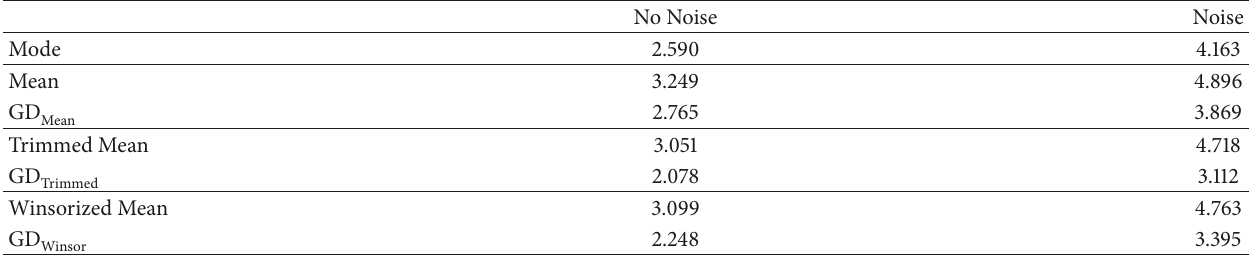
Table 77: Log-normal distributions with step noise (Type 1). The uniform noise is applied in the range from the minimum value to the maximumvalueofthedistribution.Thefrequencyofthesamplesdecreaseslinearly,goingtocreateanoise-shapedstep.Thenoiseiscomposed of 1000 points.